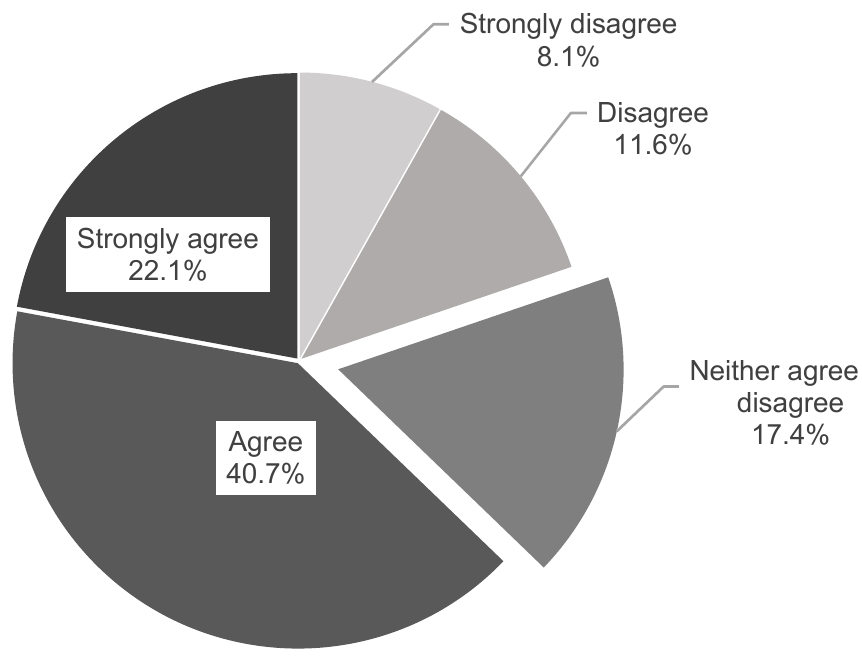
Figure 5. The respondents’ overall satisfaction with WFH arrangement.